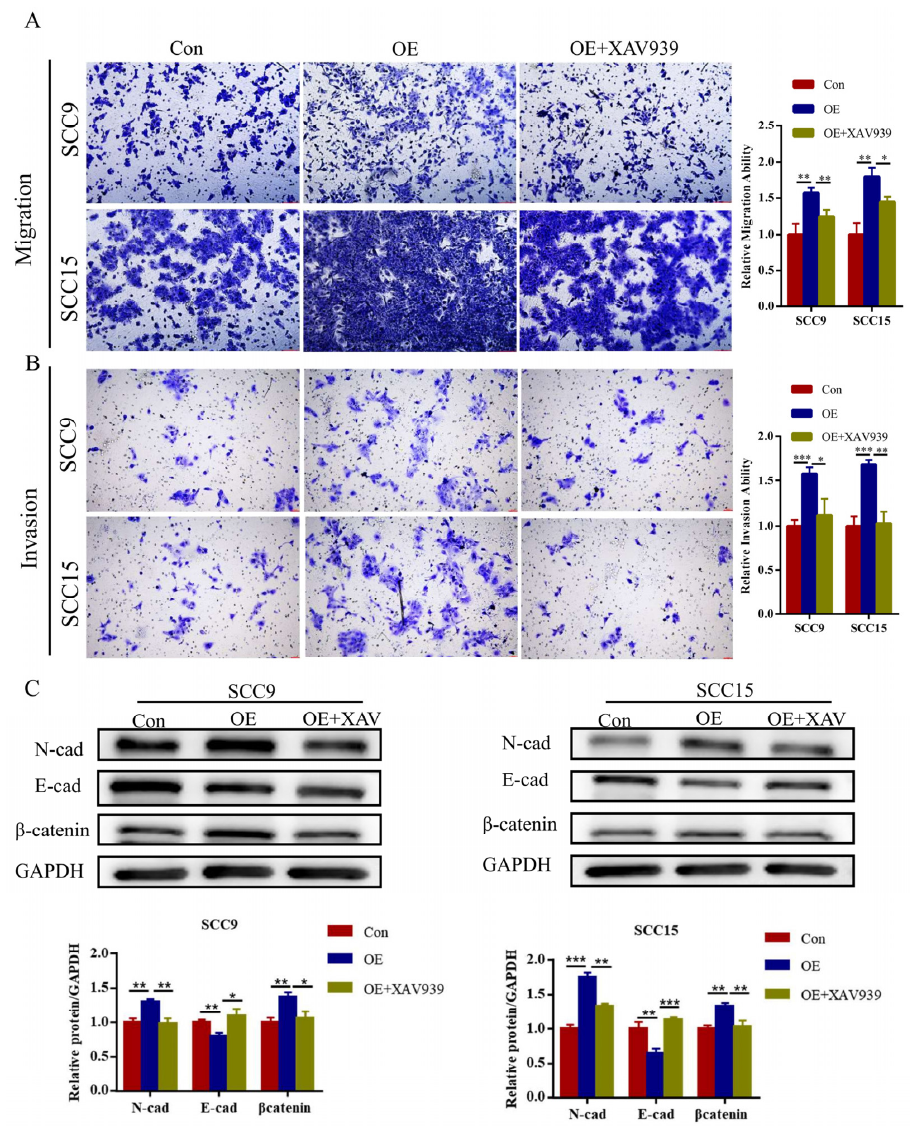
Figure 5. DEPDC1 promoted OSCC progression via the WNT/ β -catenin signaling pathway. ( A , B ), Overexpression of DEPDC1 enhanced the migration and invasion of SCC9 and SCC15, while XAV939, an inhibitor of the WNT/ β -catenin signaling pathway, could weaken the migration (SCC9 p = 0.0039; p = 0.0081, SCC15 p = 0.0024; p = 0.0134) and invasion ability (SCC9 p = 0.0005; p = 0.0138, SCC15 p = 0.0005; p = 0.0011) after overexpression of DEPDC1. ( C ), Meanwhile, upregulation of DEPDC1 induced higher N-cad (SCC9 p = 0.0024; p = 0.0042, SCC15 p = 0.0002; p = 0.0012) and β -catenin expression (SCC9 p = 0.0021; p = 0.0114, SCC15 p = 0.0014; p = 0.0075) and lower E-cad expression (SCC9 p = 0.0047; p = 0.0131, SCC15 p = 0.0064; p = 0.0004), while the protein level could also be reversed by XAV939. N-cad: N-cadherin, E-cad: E-cadherin, Con: control, OE: overexpression of DEPDC1. Significant differences were considered at p < 0.05 *; p < 0.01 **; p < 0.001 ***.